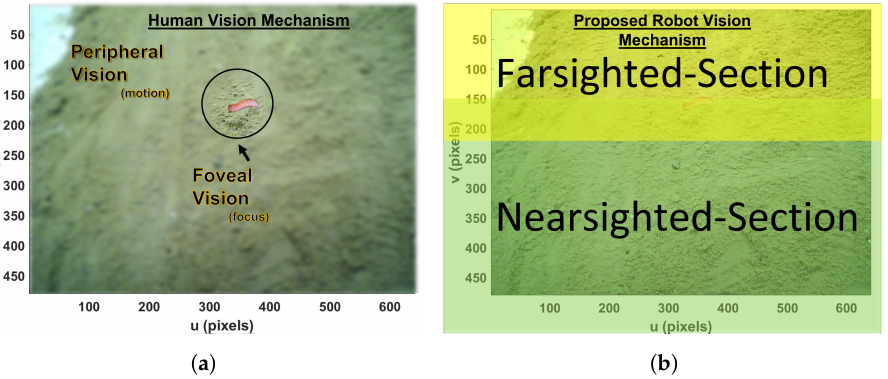
Figure 2. Modelling of human vision mechanism as the proposed insect pest larvae recognition vision mechanism. ( a ) Human vision mechanism. ( b ) Proposed robot vision